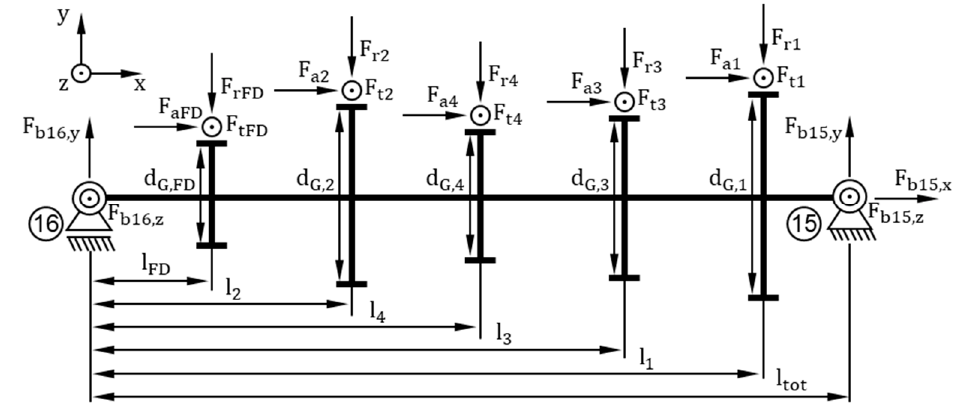
Figure 7. Force diagram of the first intermediate shaft. All forces are rotated into the section plane.